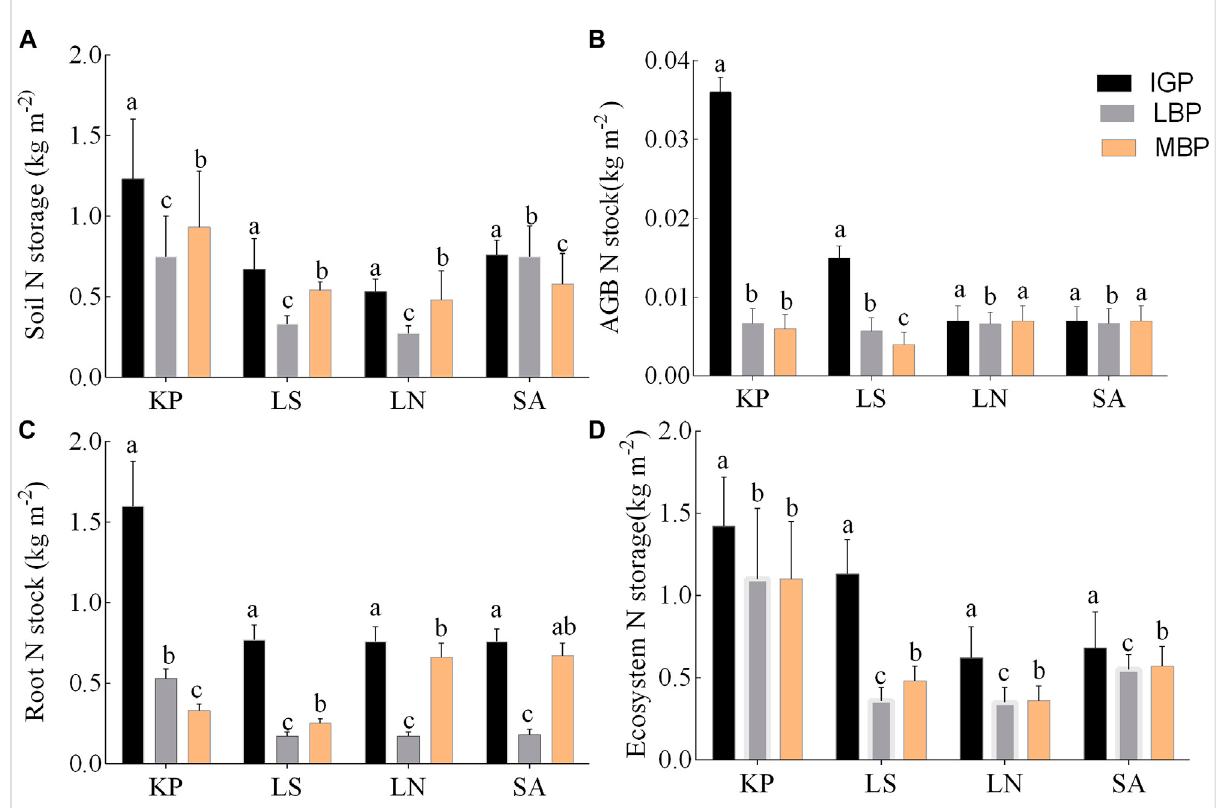
FIGURE 5 Soiltotalnitrogen (A) ,plantnitrogen (B) ,rootnitrogen (C) ,and (D) ecosystemnitrogenstorageintheselectedpatches.Barswithdifferentletters show signi fi cance at p < 0.001. IGP; intact vegetation patch, LBP; large stripped vegetation patch, MBP; medium stripped vegetation patch, KP; Koeleria pers patch, LS; Leymus secalinus patch, LN; Leontopodium nanum patch, SA; Stipa aliena